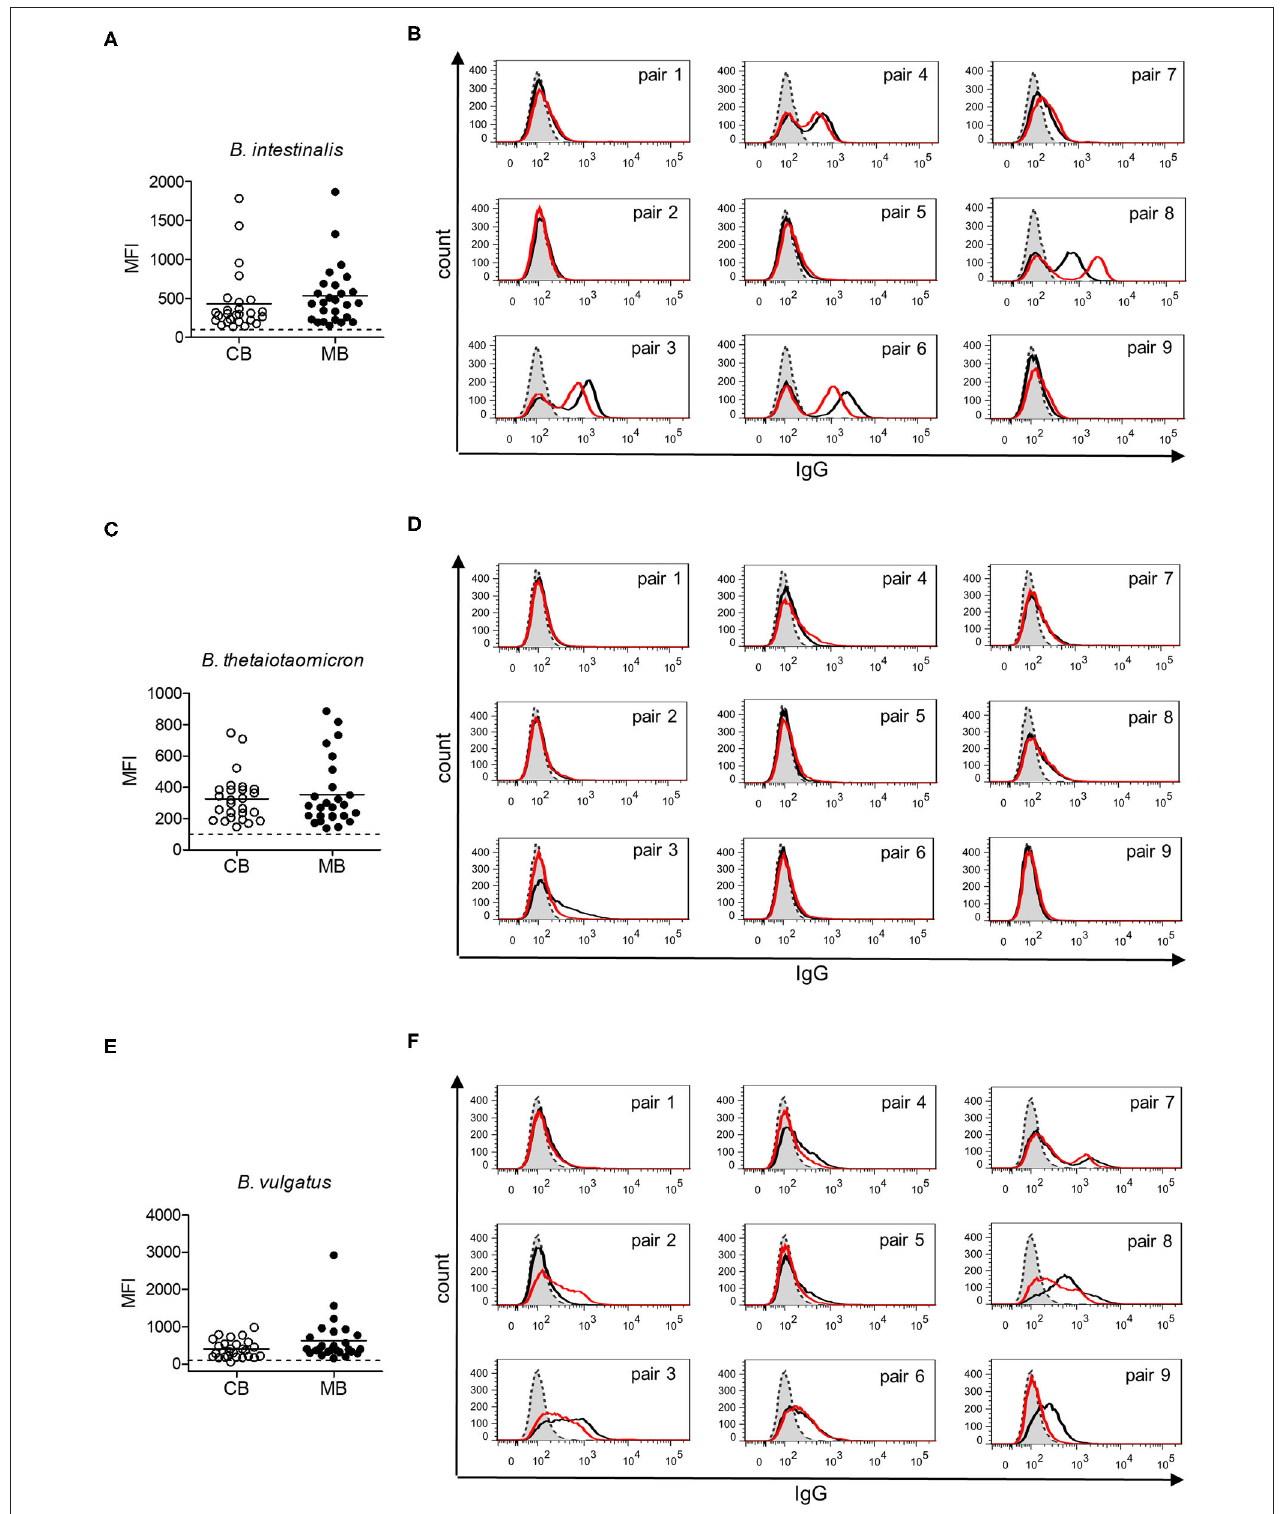
FIGURE 5 | IgG response to commensal intestinal bacteria is comparable in matched cord blood and maternal blood samples. (A) IgG reactivity to B. intestinalis for cord blood (CB) and maternal blood (MB) samples ( n = 26). (B) IgG reactivity to B. intestinalis for matched pairs of cord blood (red) and maternal blood